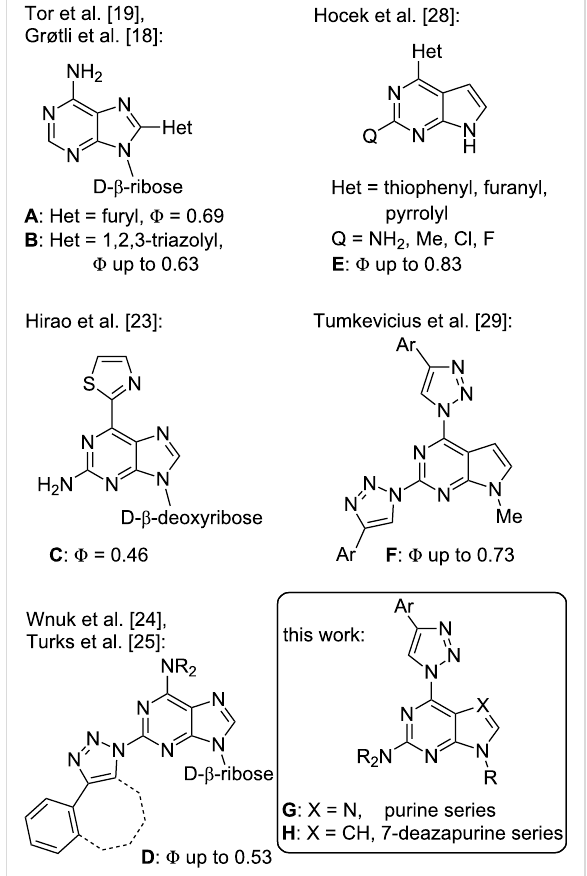
Figure 1: Examples of fluorescent purine/7-deazapurine derivatives.